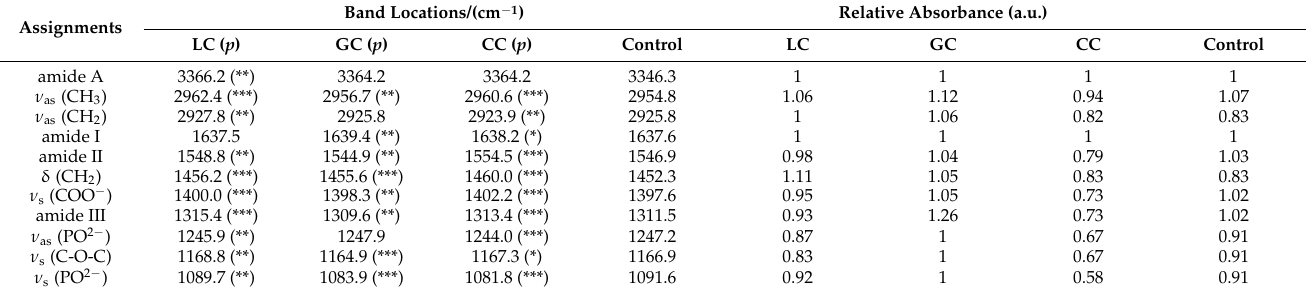
Figure 2. ATR-FTIR profiles of different liquid DTCs, including three types of LC, GC, CC, and control serum samples and its signature analysis of DTCs. ( a ) Average original spectra of DTCs and control samples, annotated with absorption peaks of major molecular vibrations: ν stretching, δ bending, s symmetric, and asymmetric vibrations. ( b ) Average SD-FTIR spectra of DTCs and control samples, characterized by the variations of positions and relative contents of significant molecular compositions. Table 1. Standardized spectra: Distribution and statistical comparison of DTC and control spectra in terms of band position and relative